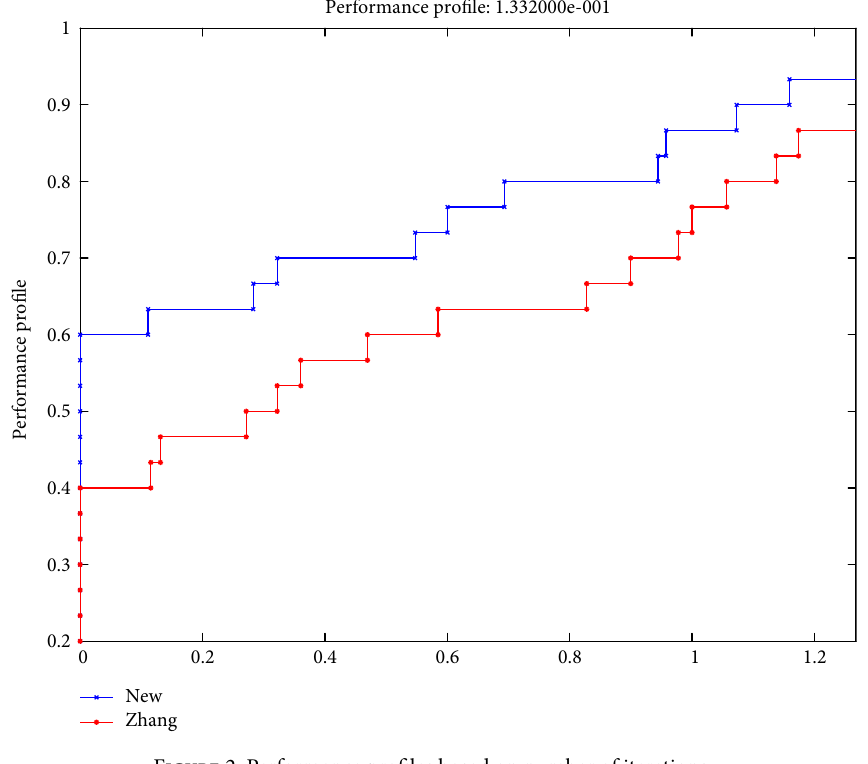
Figure 2: Performance profiles based on number of iterations.